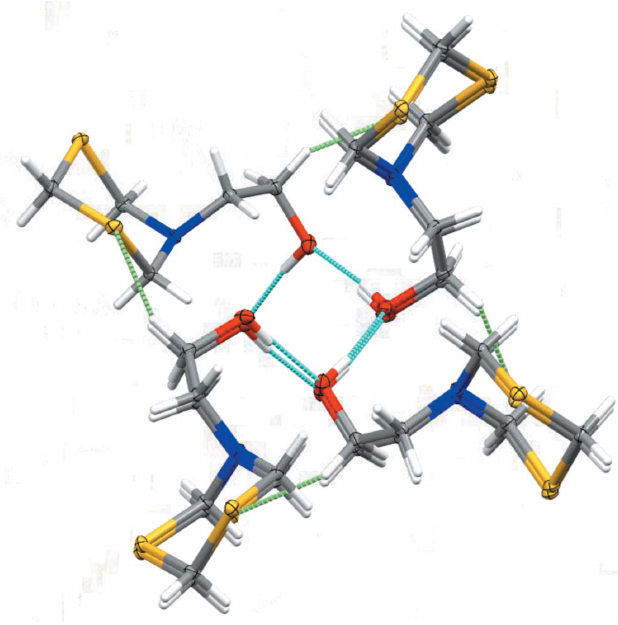
Figure 5 Partial packing view and hydrogen bonding in the form I polymorph, viewed at a slight angle along the c axis (4 1 -screw-axis direction). Turquoise dashed lines: O—H (cid:2)(cid:2)(cid:2) O hydrogen bonds. Light-green dashed lines: weak C—H (cid:2)(cid:2)(cid:2) S interactions. Coordinates from Wang et al. (2020). Displacement ellipsoids are shown at the 50% probability